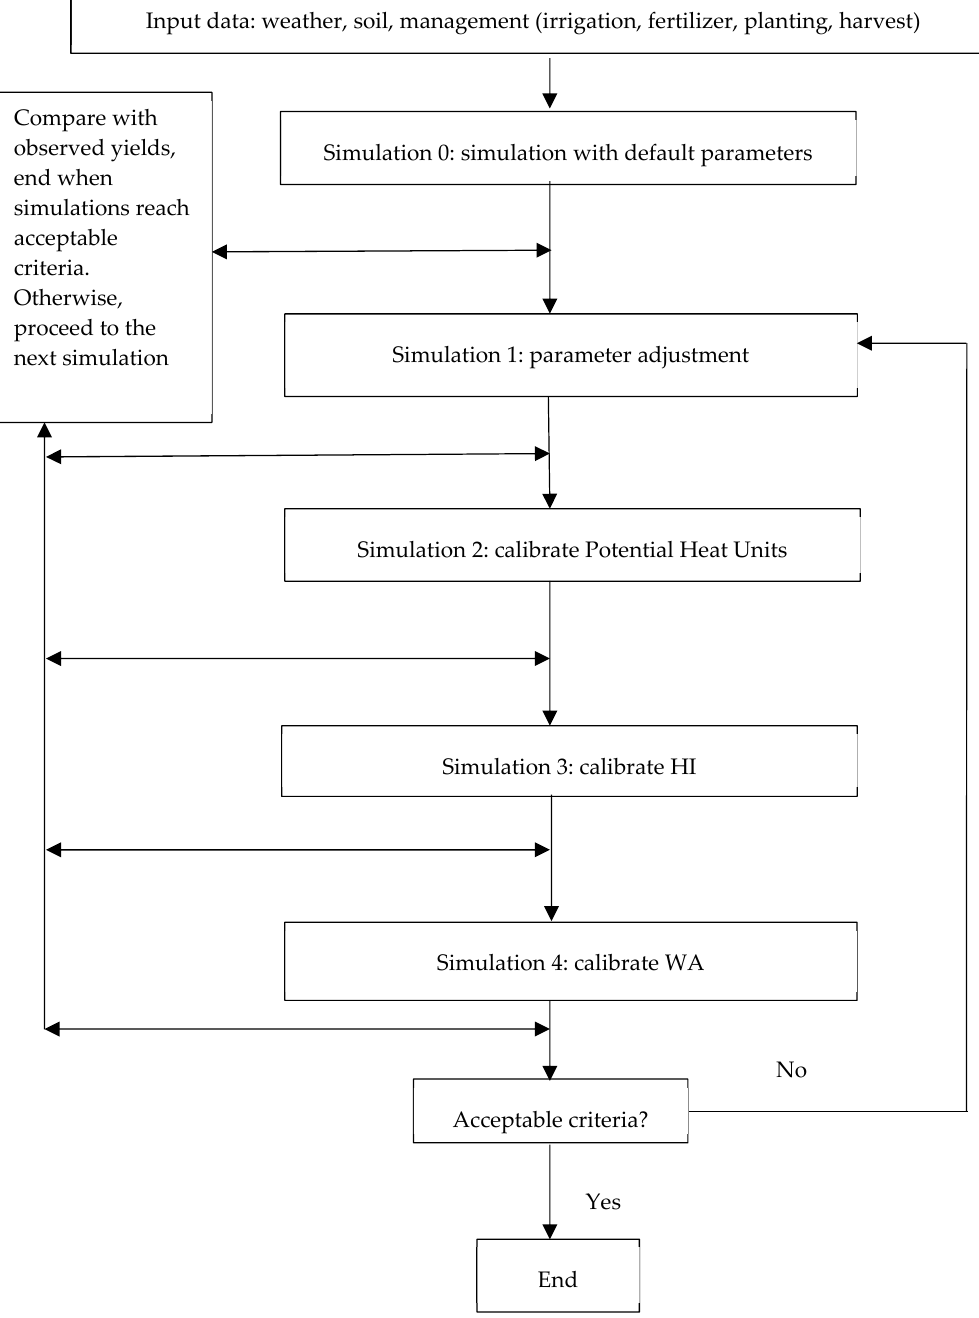
Figure 2. Steps followed in the calibration process (adapted from [12]).